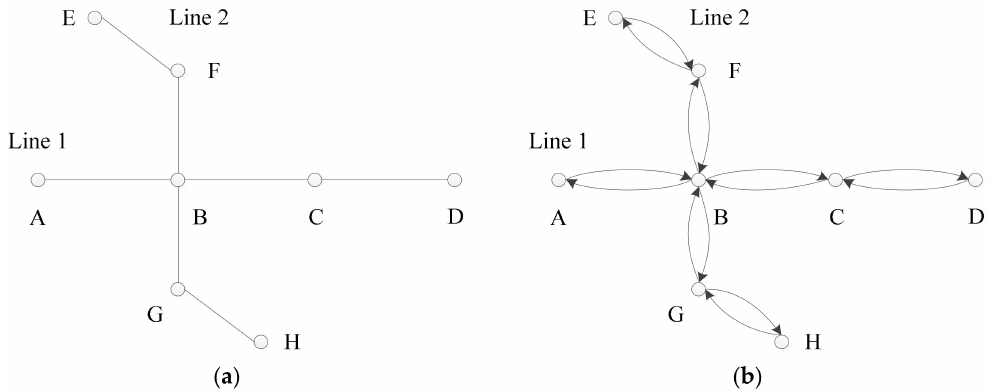
Figure 3. ( a ) A sample subway network with eight nodes and seven edges. ( b ) Passenger flow network with eight nodes and 14 directed